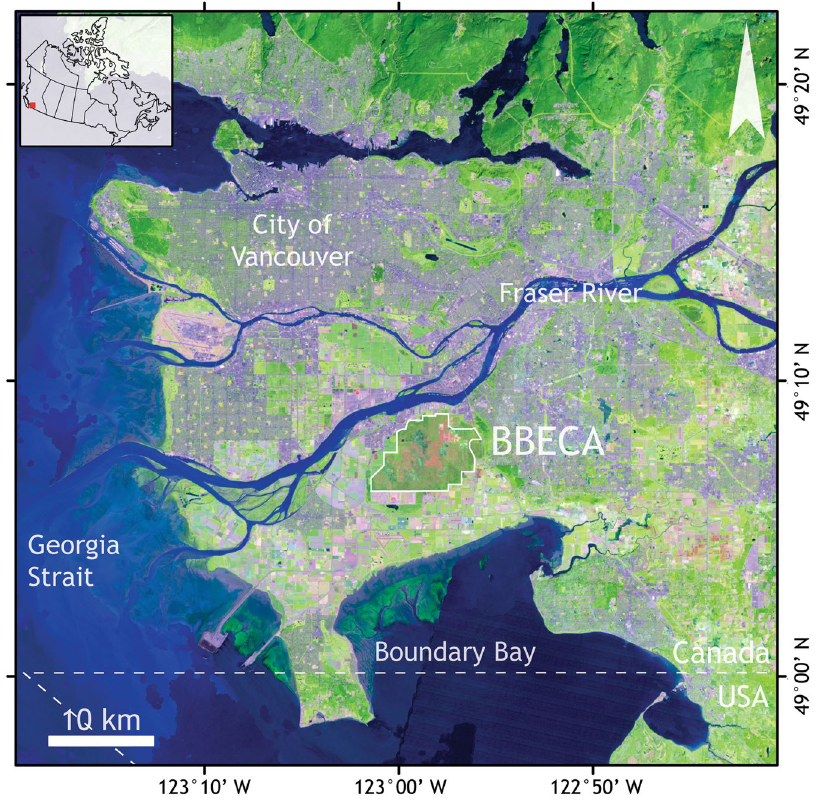
Figure 1. Location of the BBECA within the lower mainland of British Columbia, Canada. Background image from Landsat best available pixel composite 45–50 . Maps generated using ESRI ArcGIS 10.3 (http://www.esri.com/